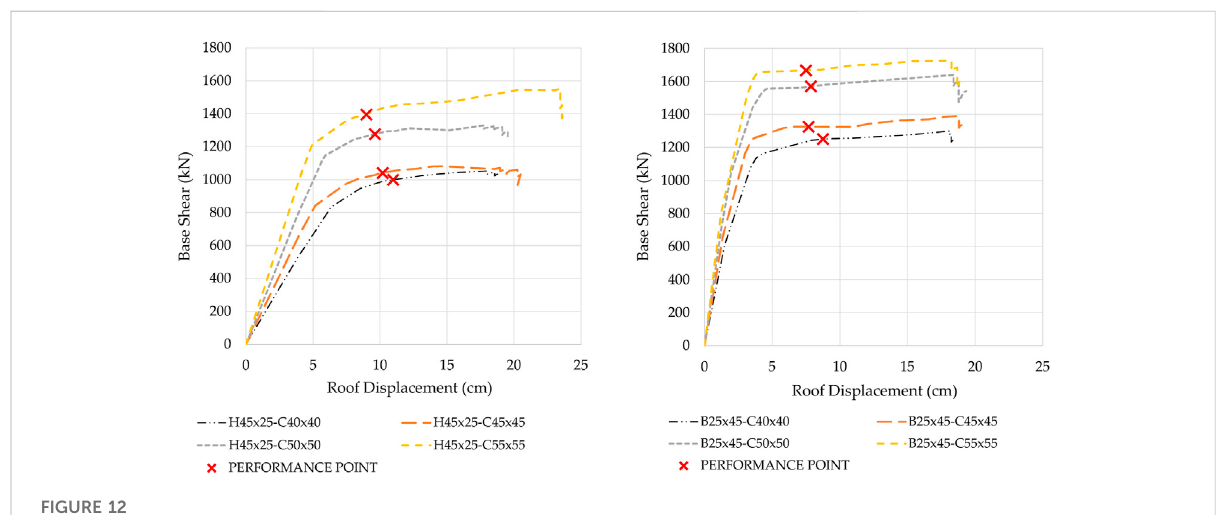
FIGURE 12 H45 × 25 and B25 × 45 Pushover